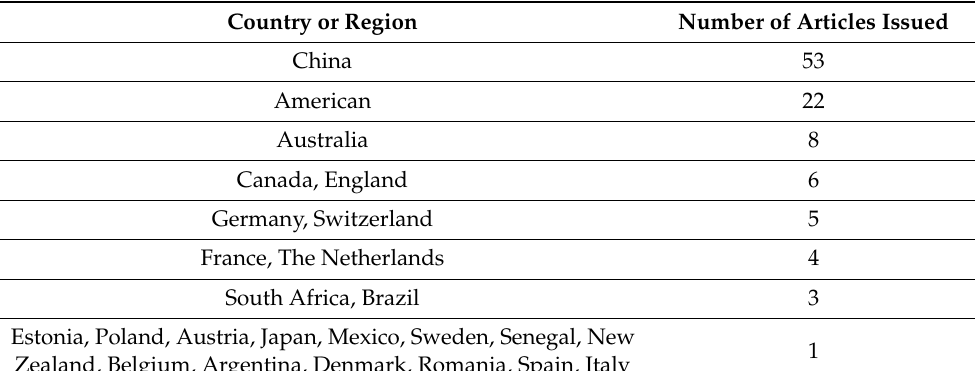
Table 1. Distribution of the number of publications issued by countries or region. Country or Region Number of Articles